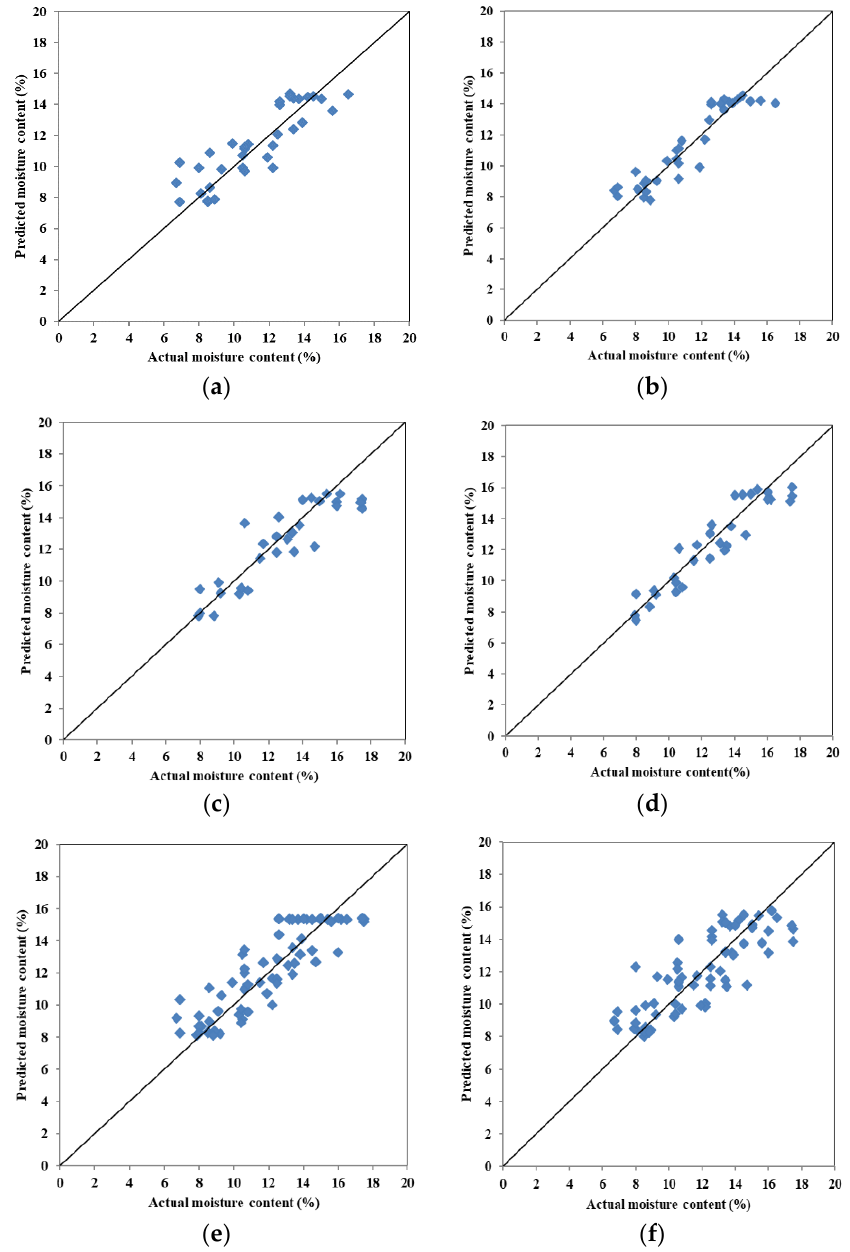
Figure 2. Graphical prediction accuracy of model for predicting moisture content, ( a ) field, without velocity, ( b ) field, with velocity, ( c ) lab, without velocity, ( d ) lab, with velocity, ( e ) field plus lab, without velocity, ( f ) field plus lab, with velocity.